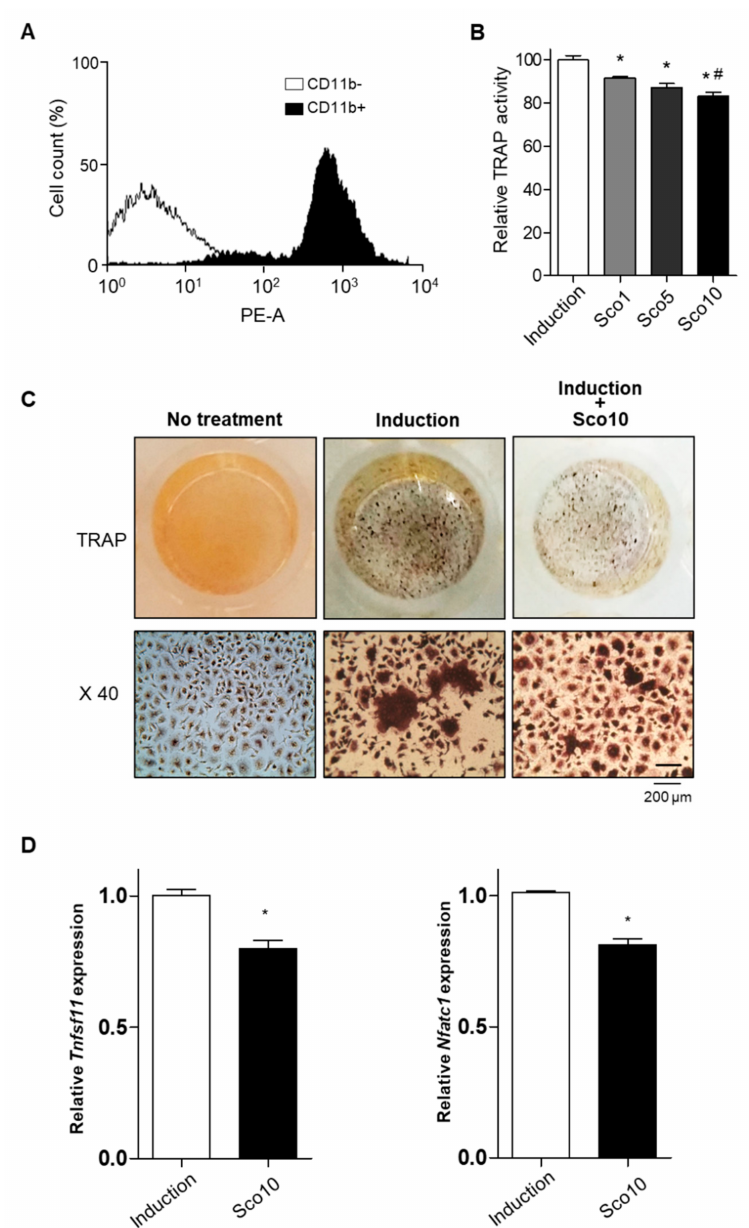
Figure 4. Scopolin treatment decreased the cellular di ff erentiation of osteoclast cells isolated from bone marrow. ( A ) Monocytes successfully isolated from mouse bone marrow were identified by immunophenotypic analysis with a monocyte-specific surface positive marker (cluster of di ff erentiation molecule 11B (CD11b) antibody). ( B , C ) Monocyte cells were cultured for 5 days and osteoclast di ff erentiation was analyzed via ( B ) tartrate-resistant acid phosphatase (TRAP) activity assay and ( C ) TRAP staining. ( D ) The mRNA levels of osteoclast markers (tumor necrosis factor (ligand) superfamily, member 11 ( Tnfsf11 ), and nuclear factor of activated T cells cytoplasmic 1 (Nfatc1 )). X40: 40x magnification of TRAP staining. Induction: Non-scopolin-treated monocytes. * p < 0.05 vs. Induction, # p < 0.05 vs. Sco1 (Tukey’s honest significant di ff erence post hoc test, analysis of variance). All the experiments were repeated three